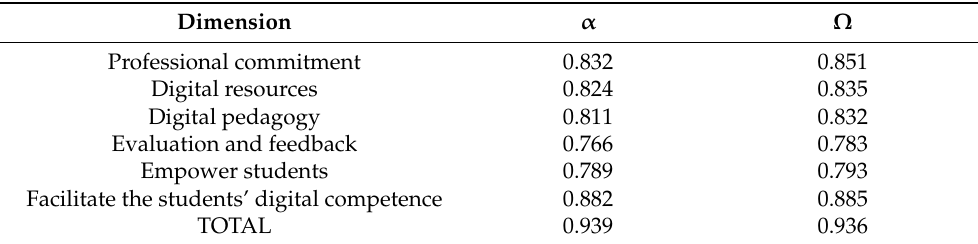
Table 1. Reliability coefficients.